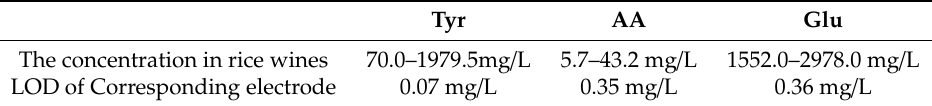
Table 2. The Concentrations and Limits of Detection (LOD) of Tyr, AA, and Glu.